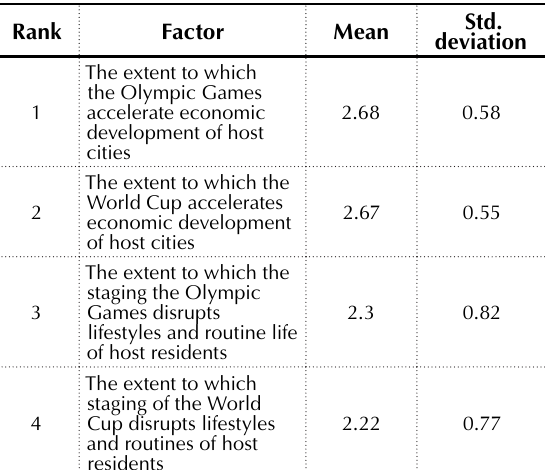
Table 2. Mean and standard